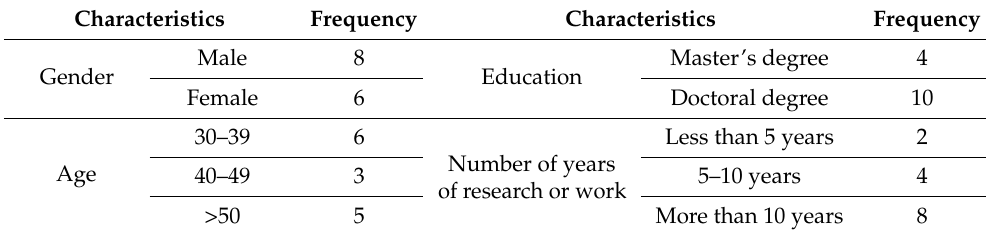
Table 2. Descriptive statistics of survey participants.